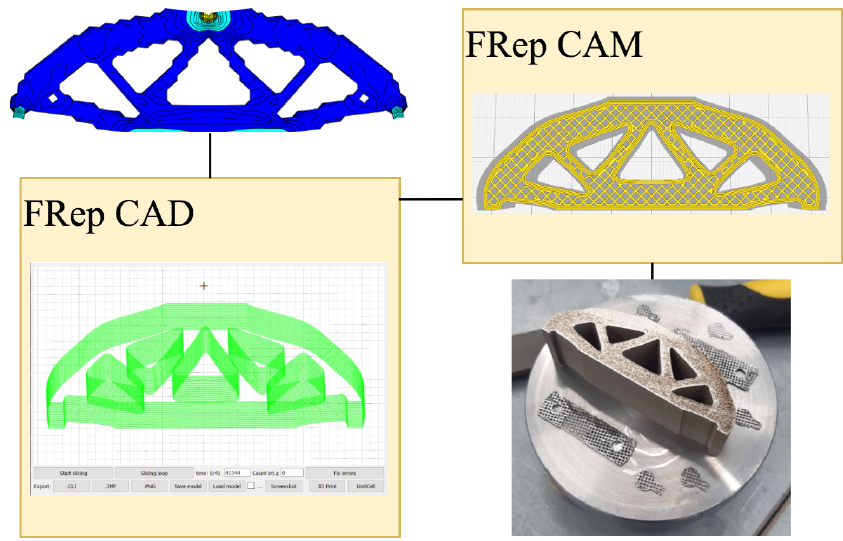
Figure 6. Realized components of the FRep system.